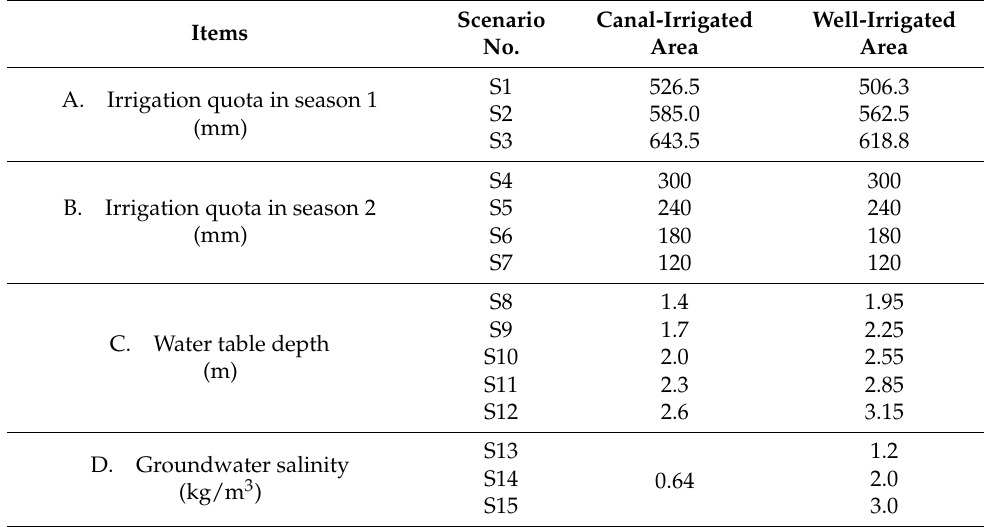
Table 2. Water-saving irrigation scenarios in canal- and well-irrigated areas.